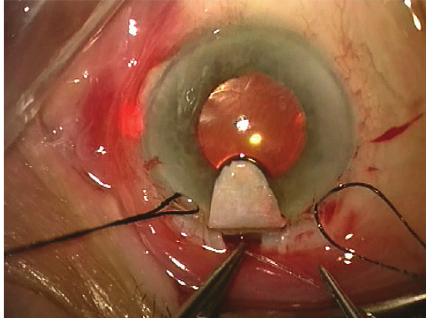
Figure 7: A flexible microcatheter is inserted into Schlemm’s canal which is circumferentially viscodilated. The blinking light at the distal tip of the microcatheter helps to identify the track of the microcatheter.